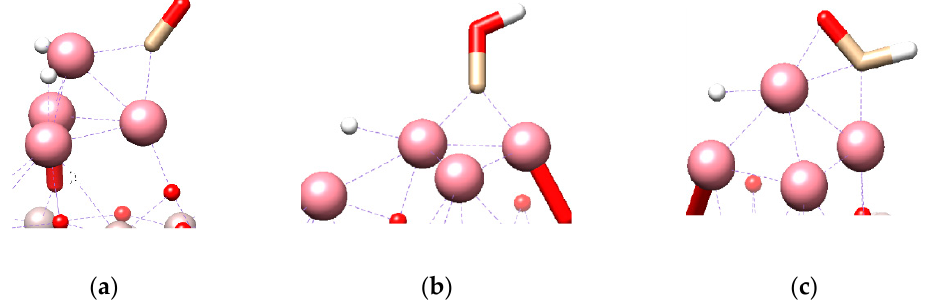
red—oxygen atom, white—hydrogen atoms, violet—cobalt atoms; symbols (i) and (f) denote the Figure 5. The optimized structures of I-1 (a), I-2 (b), and I-3 (c) (colors: brown — carbon atom, initial and red — oxygen atom, white — hydrogen atoms, violet — cobalt atoms; symbols (i) and (f) denote the initial and final.